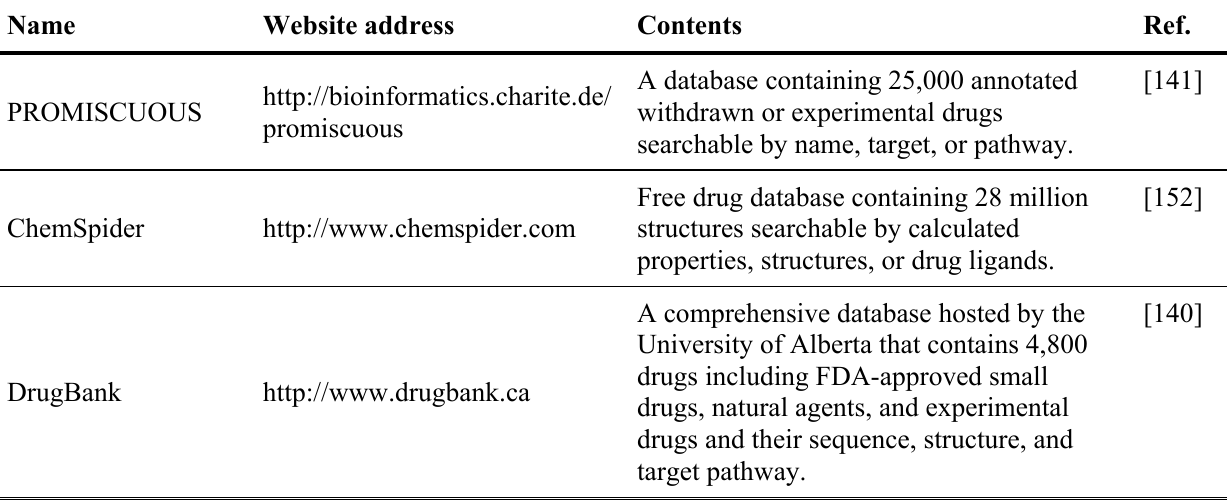
Table 4. Other drug databases and references such as PubChem (http://pubchem.ncbi.nlm.nih.gov), ChEMBL (https://www.ebi.ac.uk/chembl), and the Clinician’s Pocket Drug Reference (Scut manual) can also be used for this purpose. Candidate drugs can then be tested in vitro and in vivo for their efficacy as disease therapeutics, before initiating clinical trials. Table 4. Examples of comprehensive online databases containing available drugs and their gene targets to aid drug repurposing